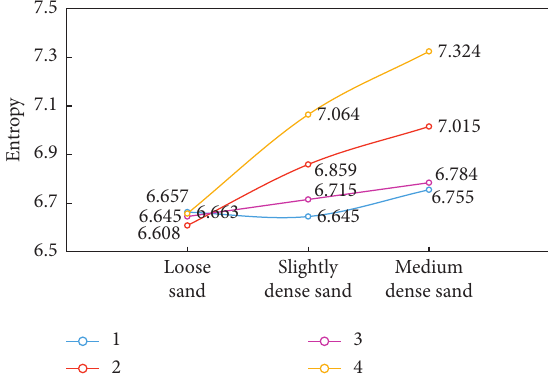
Figure 8: Entropy of middle dense sand.